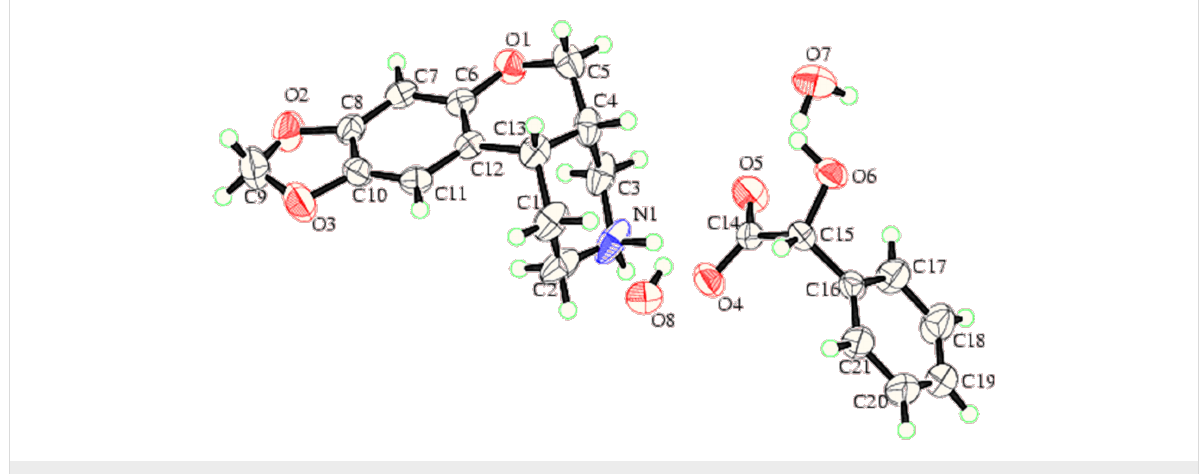
Figure 4: Molecular structure of the mandalate salt.